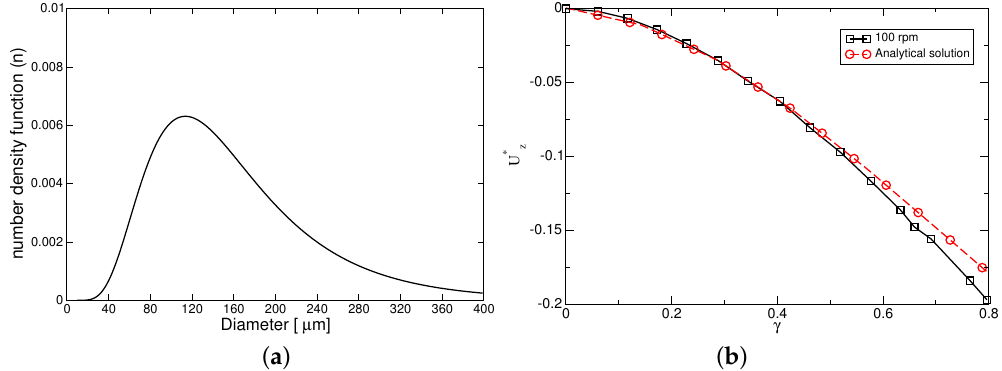
Figure 9. ( a ) The continuous distribution function imposed at the electrode surface (Nierhaus et al. [66]); ( b ) mean axial velocity component profile u z ∗ = u z √